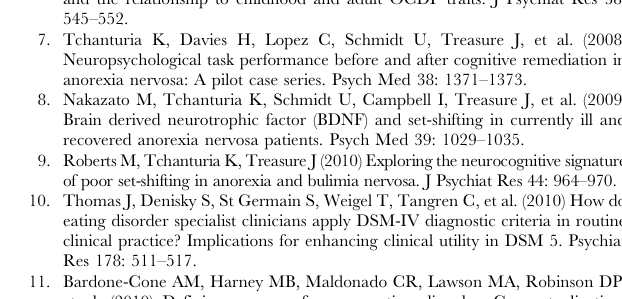
Effect size in comparison to